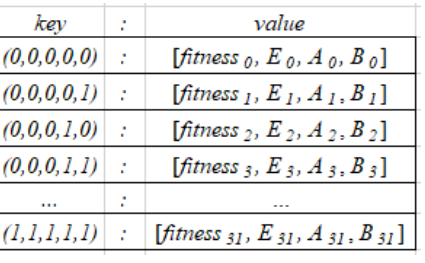
Figure 8. Example of memory